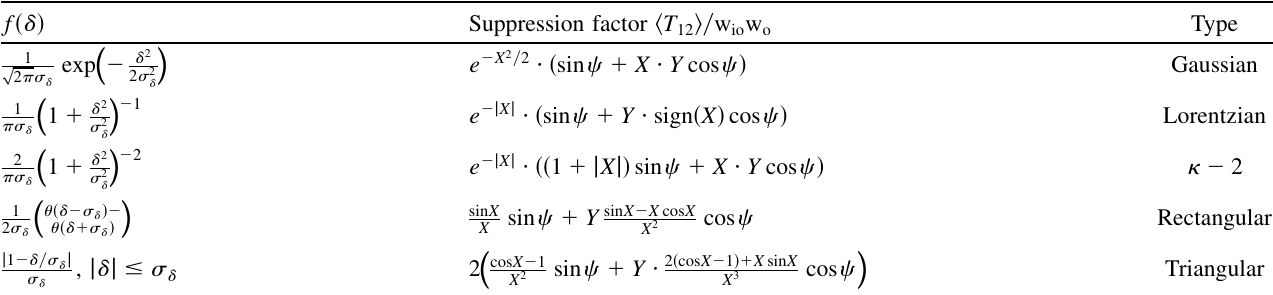
; Y ¼ v(cid:6) . (cid:3) (cid:3)